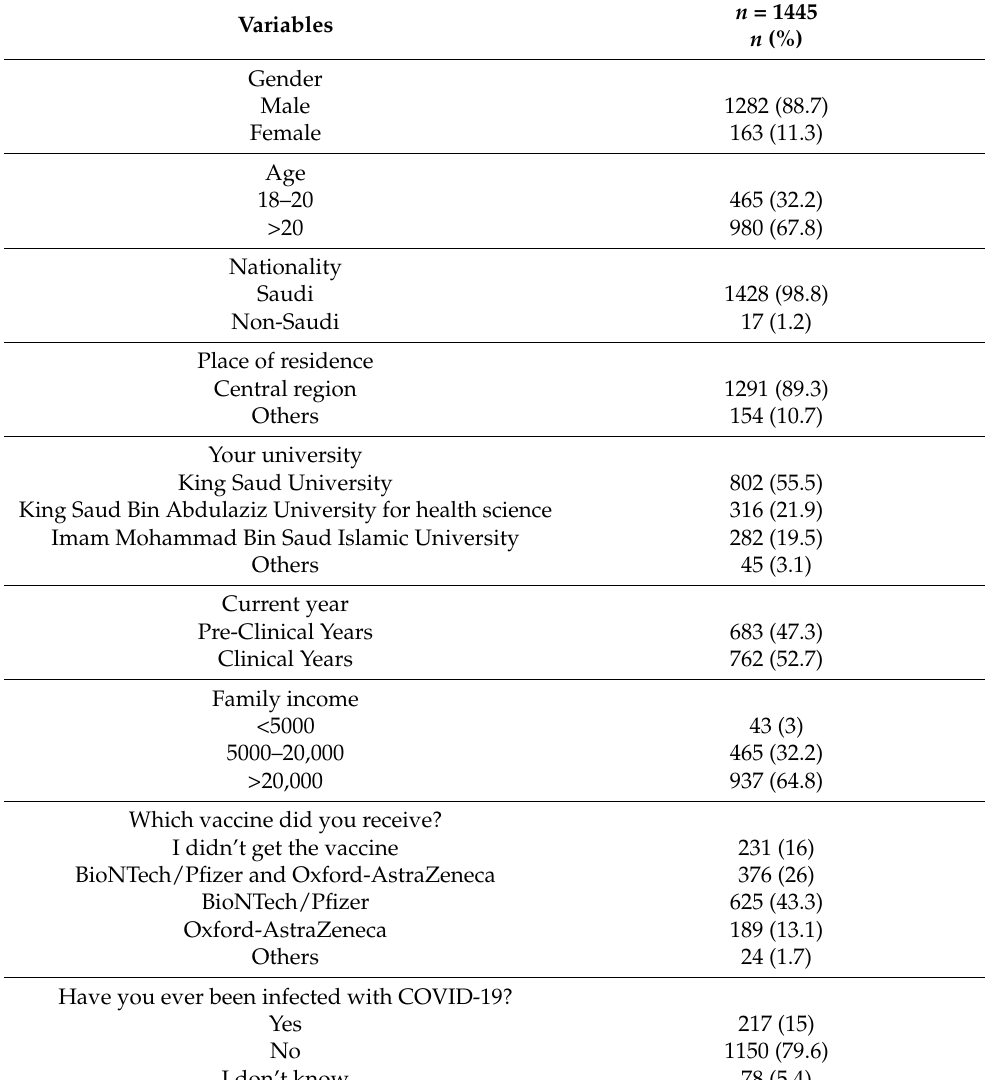
Table 1. Sociodemographic characteristics of